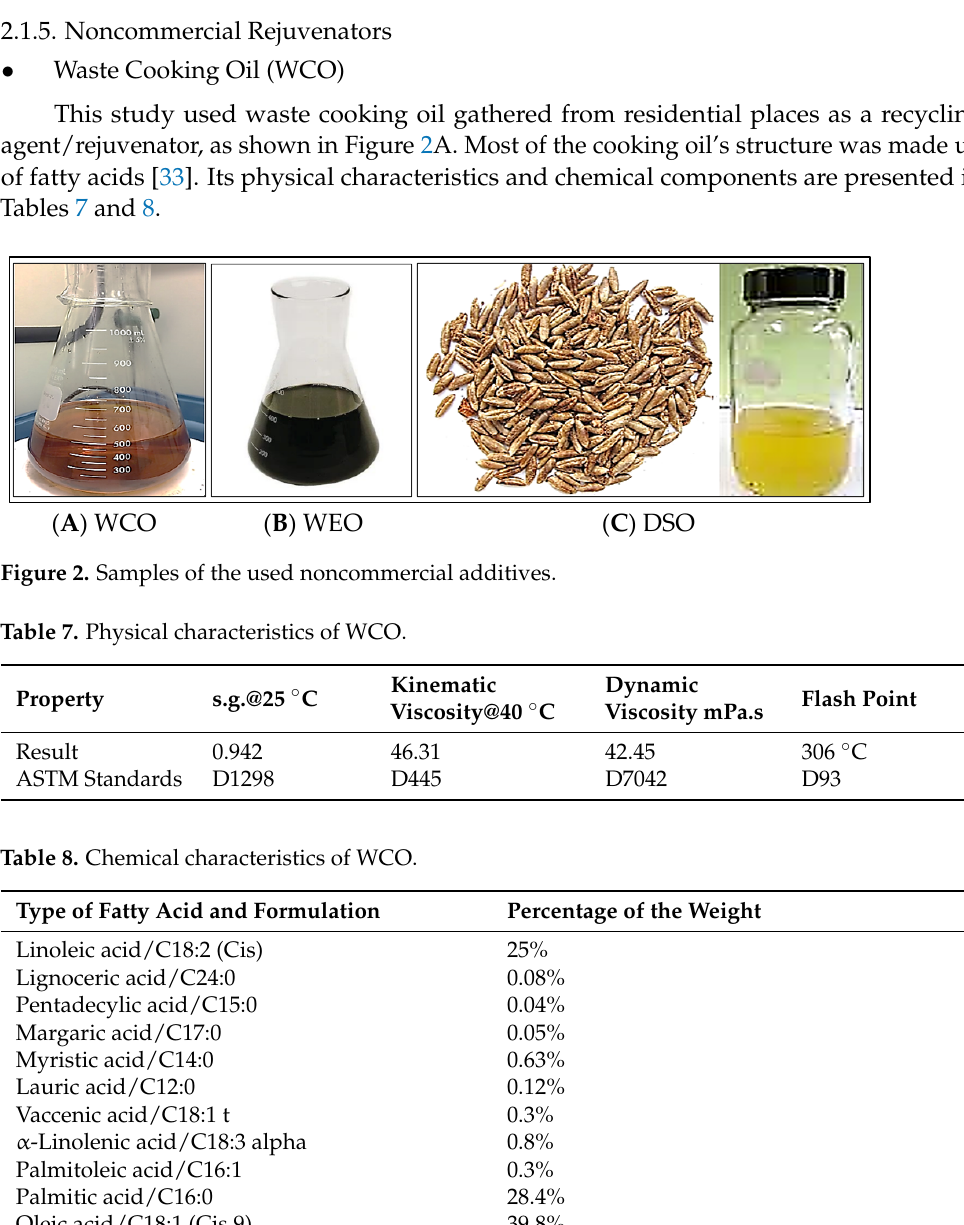
Table 11. Chemical characteristics of DSO.